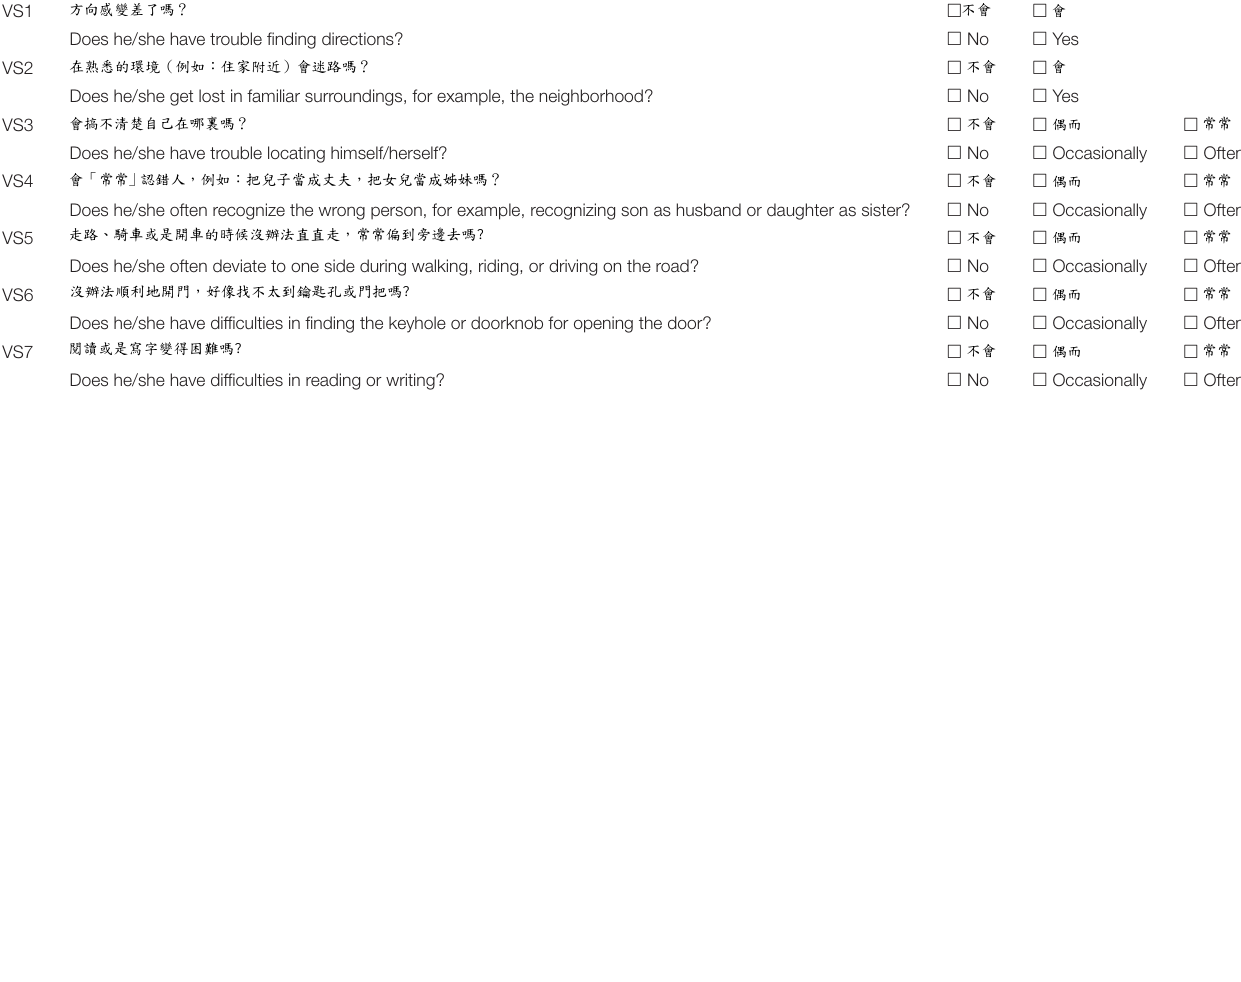
TABLE A1 | Composition of the visuospatial questionnaire in HAICDDS (HAI-VSQ). VS1